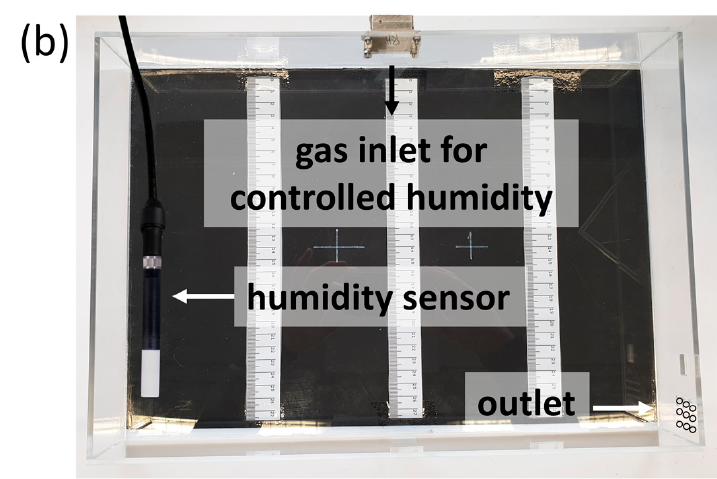
Figure 1. ( a ) Schematic and simplified sketch of the humidity chamber with the inlet and outlet of the air and a paper sample fixed with a clamp, standing upright in the chamber during humidity actuation experiments; ( b ) chamber built out of PMMA panels, connected to a humidity controller.